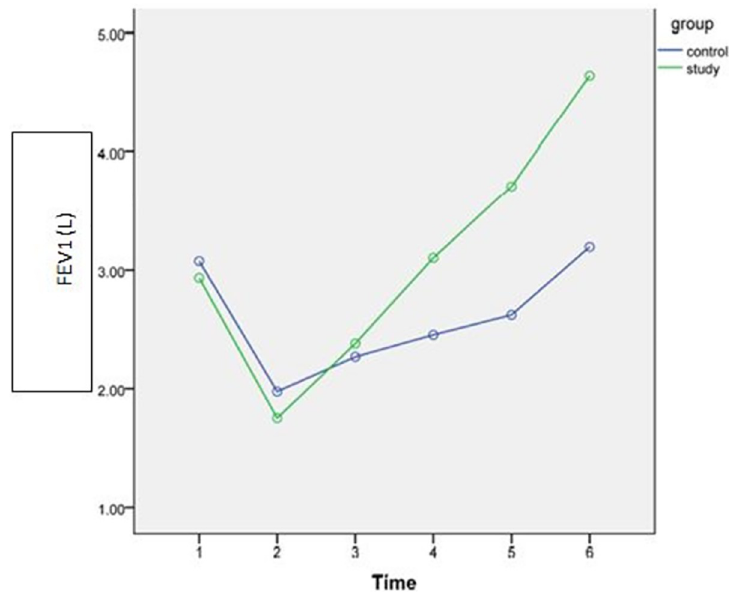
Fig 3. Estimated marginal means of FEV 1 [1: Pre-operative; 2: POD3; 3: Discharge; 4: 4 th POW; 5: 8 th POW; 6: Follow-up].